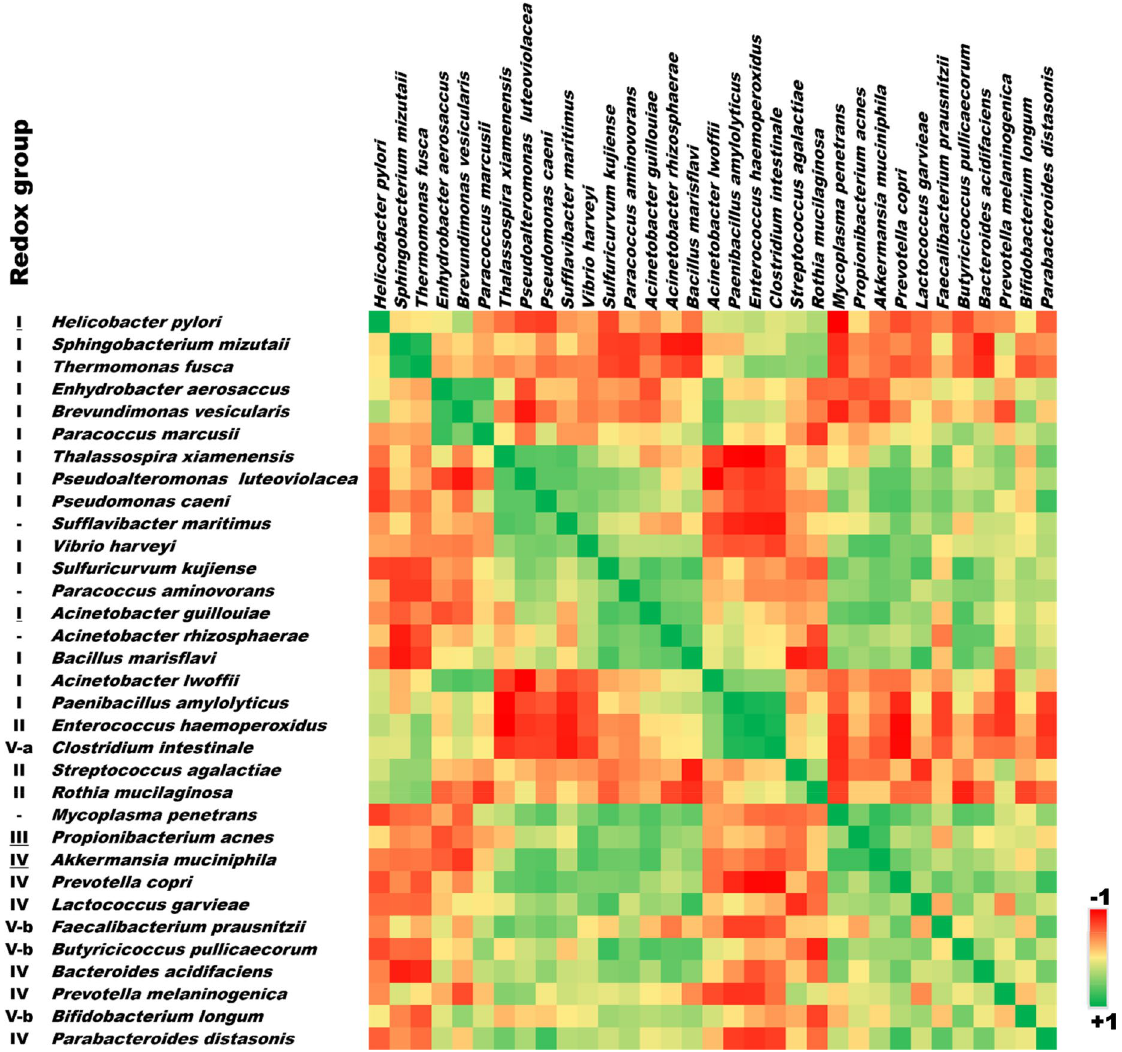
Figure 4. Color-coded Spearman correlation matrix of gastric mucosa-associated